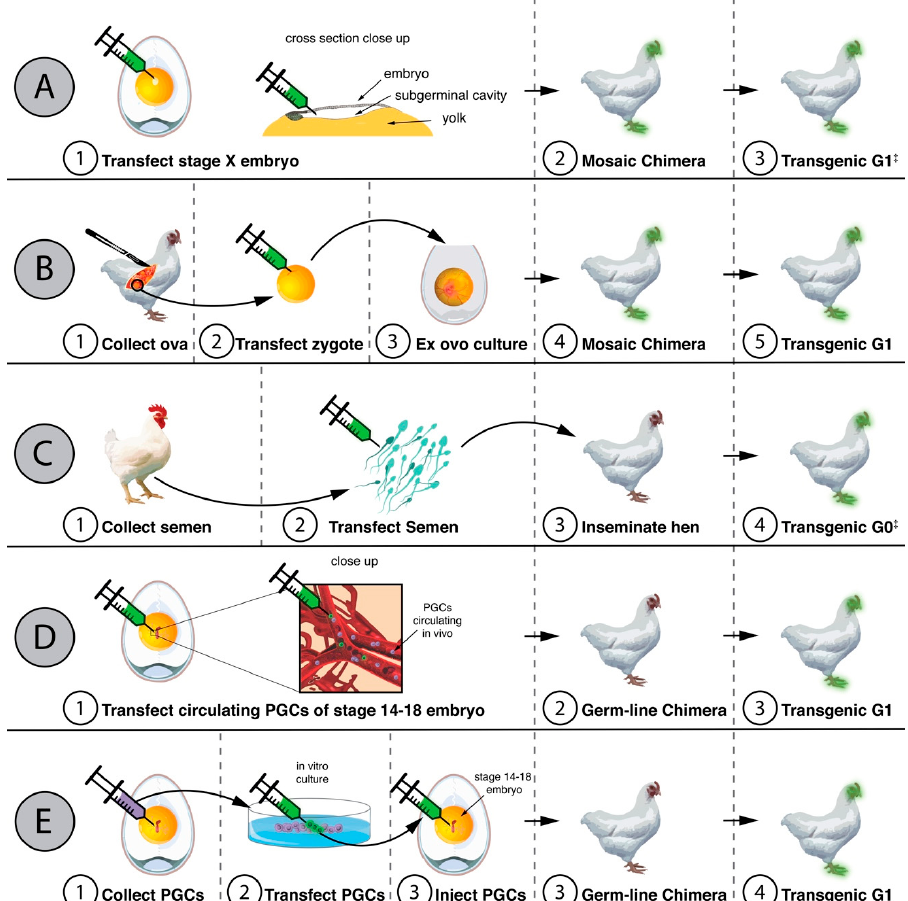
Figure 1. Methods of establishing germ-line modifications in the chicken. ( A – E ) show the workflow of integrating a transgene (e.g., GFP reporter gene) into the chicken genome, via transfection with a viral agent to the embryonic disc of a stage X chicken embryo ( A ), microinjection of transfection agents into a single cell zygote ( B ), transfection of sperm for artificial insemination ( C ), transfection of primordial germ-cells (PGCs) in vivo ( D ), and transfection of PGCs in vitro ( E ). Methods C–E have also been successful in generating targeted gene edits in the germ-line of chickens via zinc-finger nucleases, TALENs or CRISPR-Cas9. ‡ denotes methods capable of producing fully transgenic chickens in a single